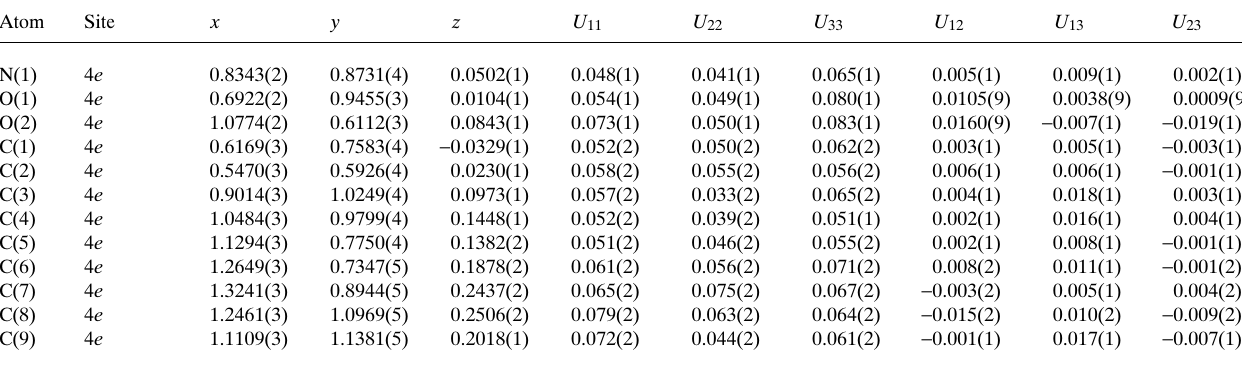
Table 3. Atomic coordinates and displacement parameters (in Å 2 ) .